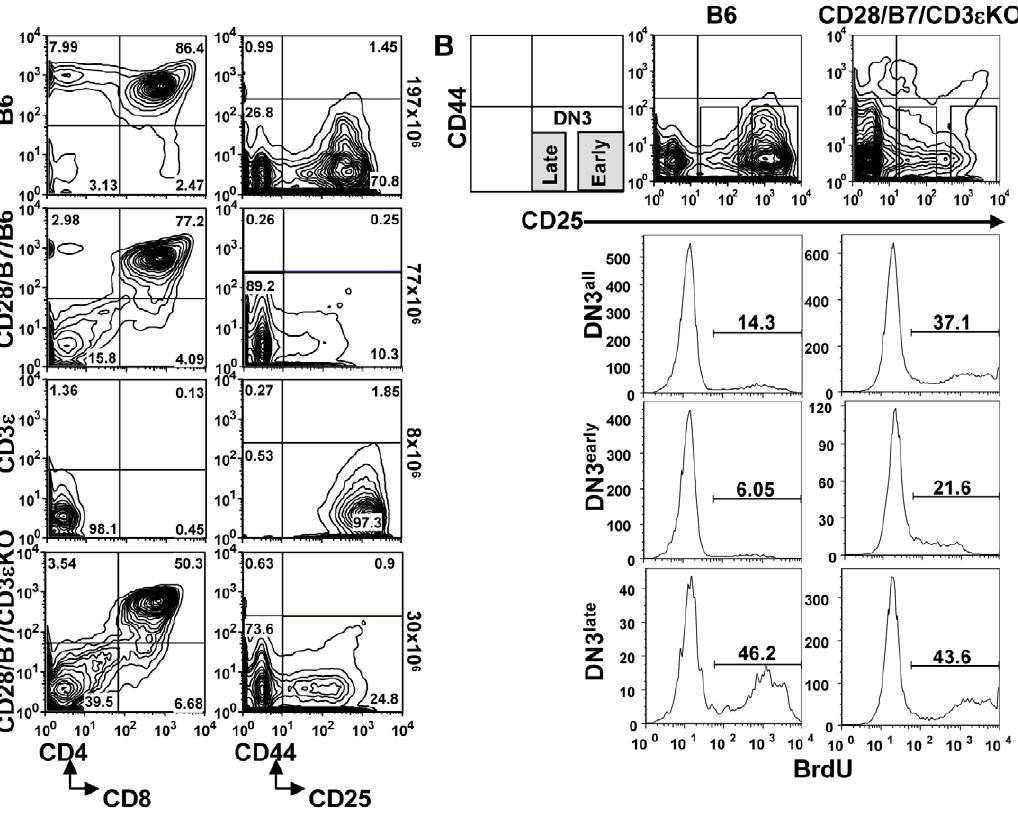
Figure 1. Analysis of thymic development and BrdU incorporation in mice undergoing pre-TCR-dependent or CD28/B7-dependent development. (A) Thymocytes from B6, CD28/B7/B6, CD3 e KO, and CD28/B7/CD3 e KO mice were analyzed for CD4-CD8 subsets (CD4-PE and CD8- Al594) or for lineage negative DN subsets (CD25-PE and CD44-APC). Thymus numbers are to the right of these figures. Staining profiles are representative of . 40 mice of each genotype analyzed. (B) Thymi were harvested from mice injected with BrdU, lineage negative cells were gated on the indicated DN subsets, and analyzed for BrdU incorporation. These histograms show the percentage BrdU + cells present in all DN3 cells, early DN3 (CD25 hi ) cells, or late DN3 (CD25 low ) cells from B6 or CD28/B7/CD3 e KO mice. This experiment is representative of three independent experiments performed.